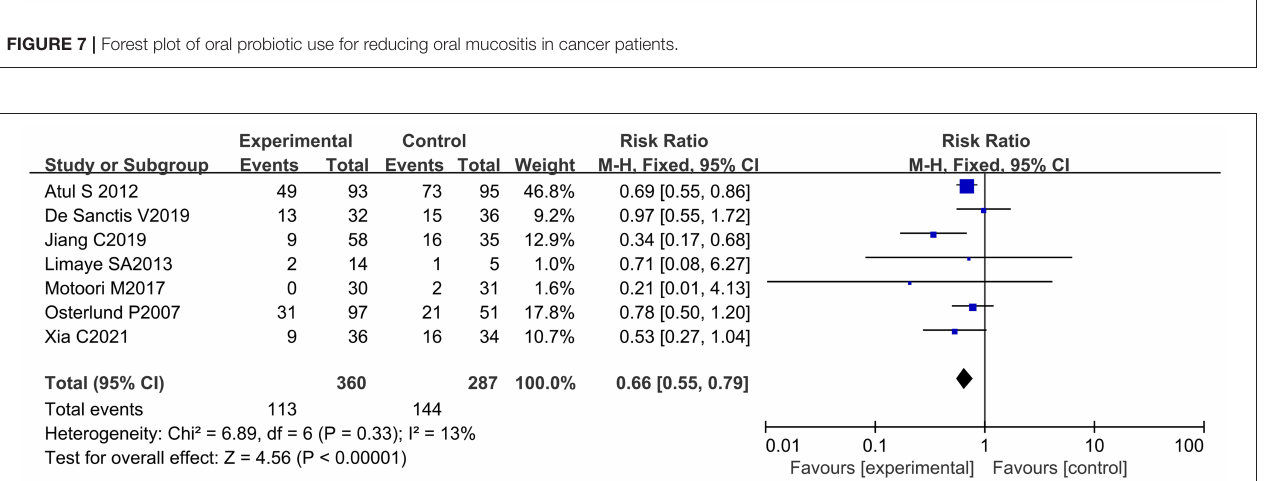
FIGURE 8 | Forest plot of orally administrated probiotics for reducing severe oral mucositis in cancer patients.